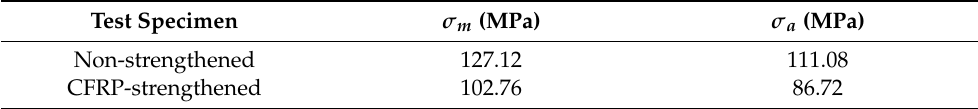
Table 9. Mean stress and alternating stress amplitude obtained from the experimental tests (corre- sponding to maximum bending moment M C for UIC 71 load